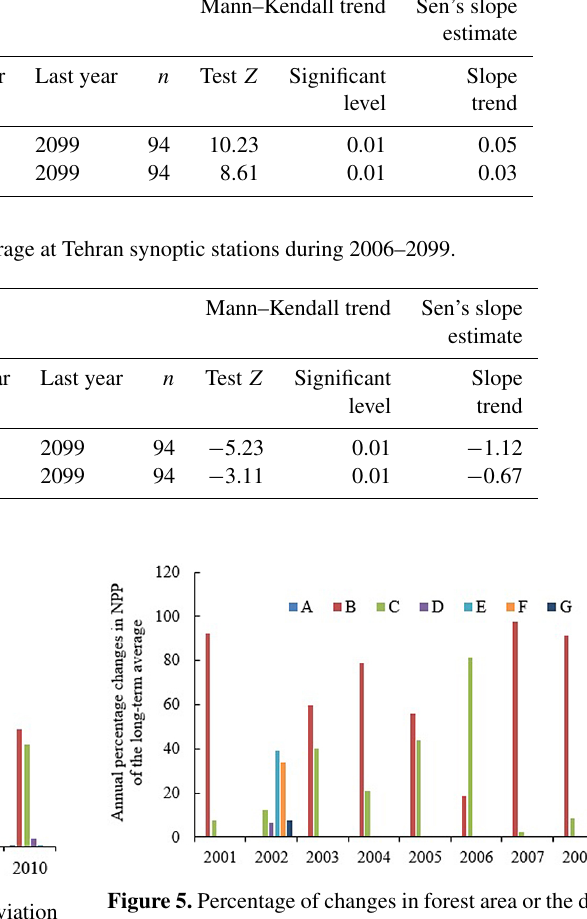
Mann–Kendall trend